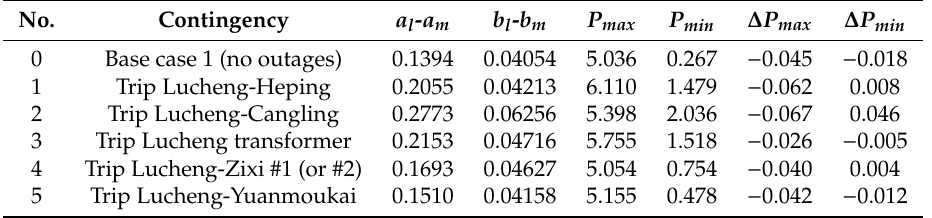
Table 1. Estimation method results under di ff erent